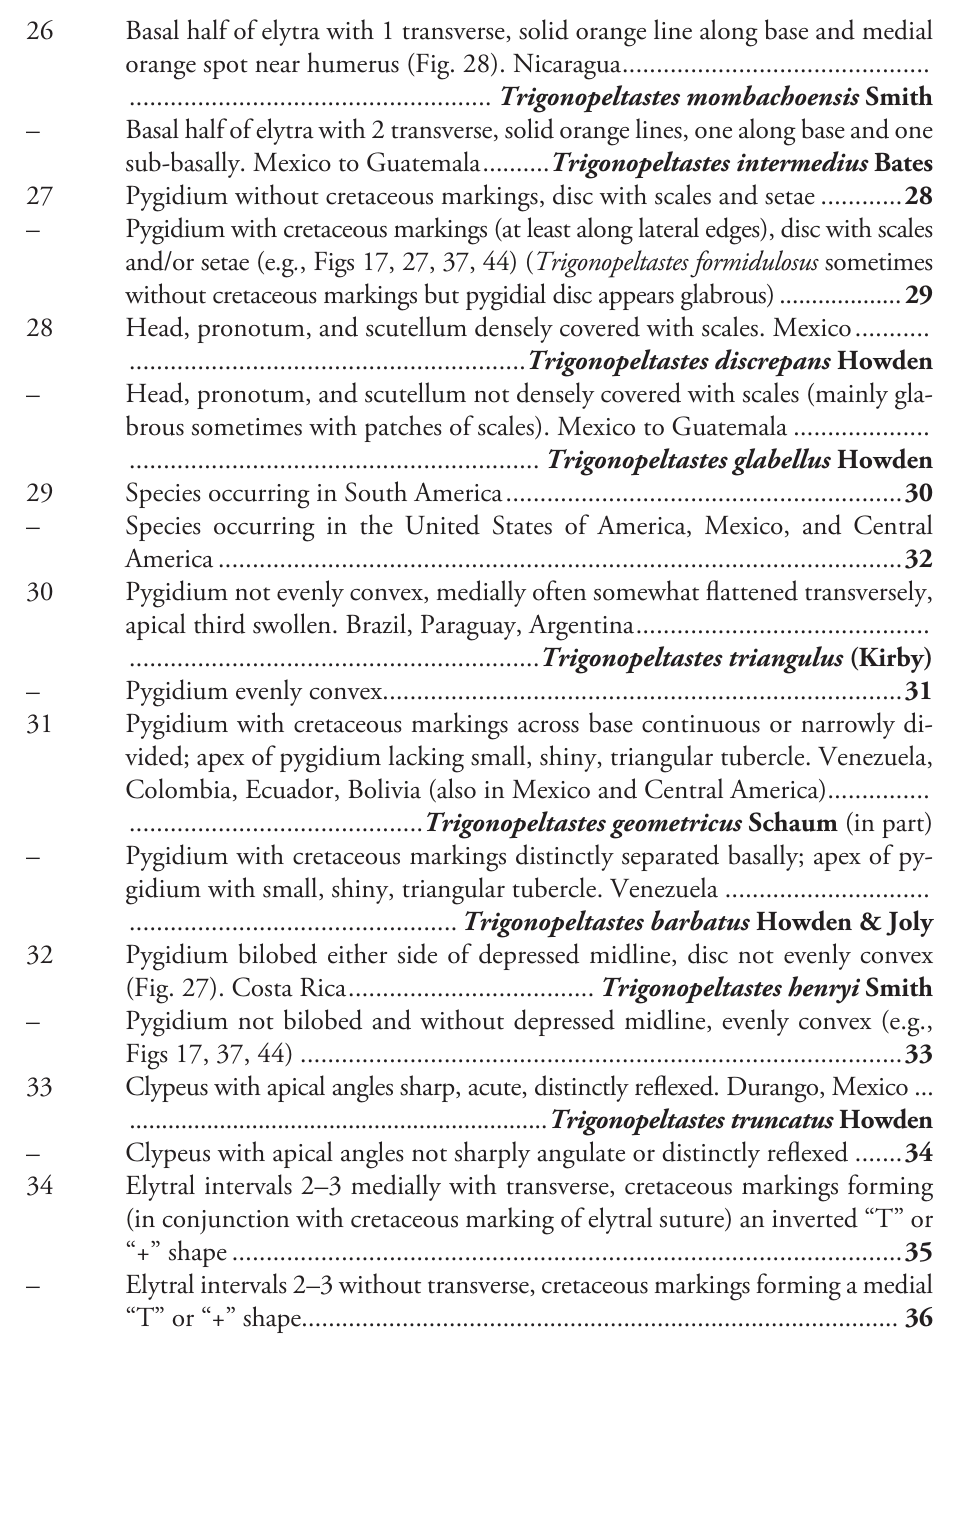
Basal half of elytra with 1 transverse, solid orange line along base and medial